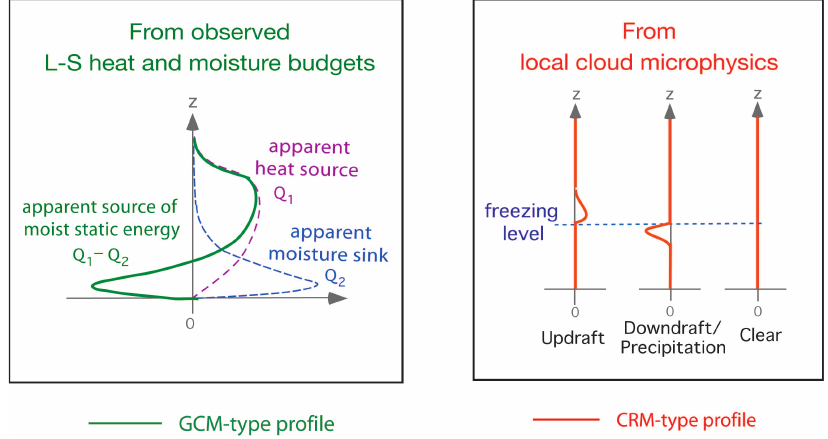
Fig. 3. Schematic illustration of typical vertical profiles of moist static energy source under disturbed tropical conditions. Redrawn from Arakawa